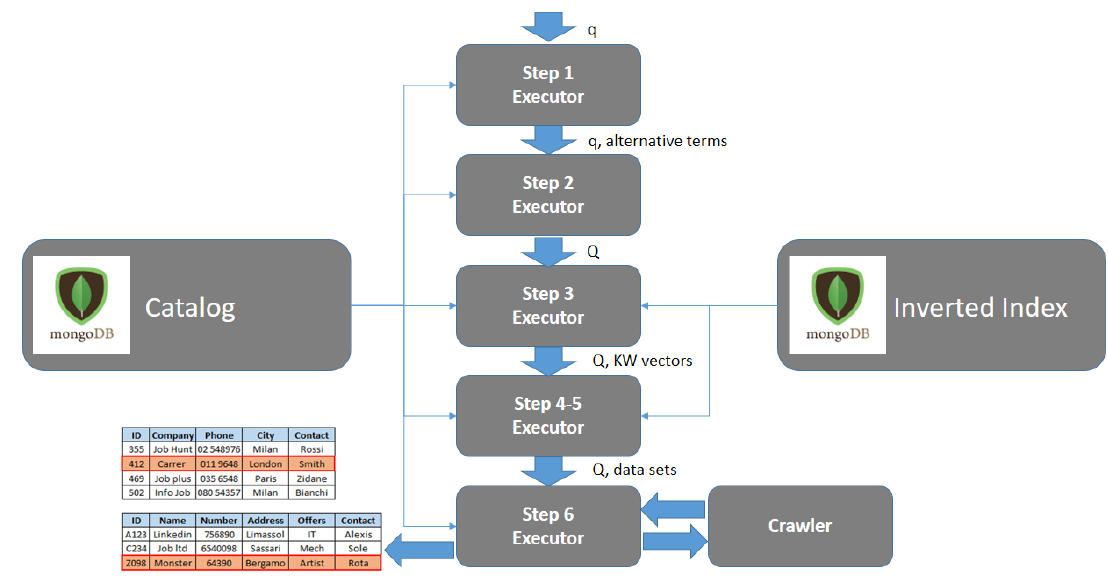
Figure 3. General architecture of the Query